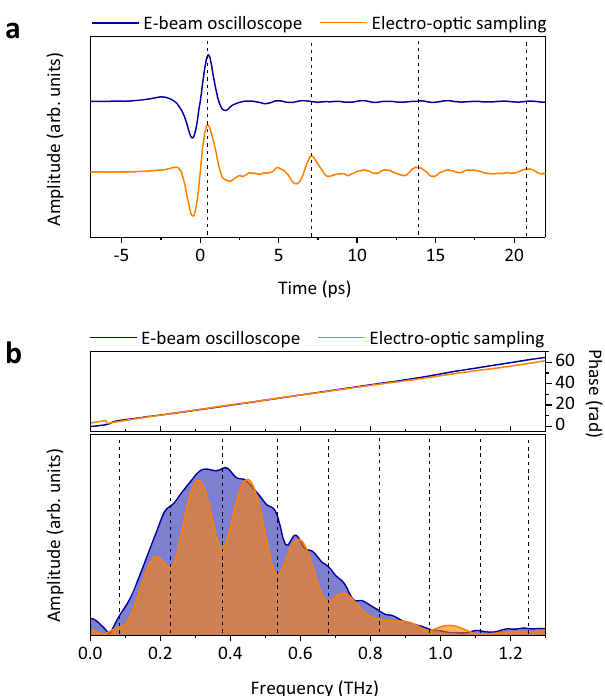
Fig. 3 Waveform comparison with conventional EOS. a Single-shot THz waveform recorded by the electron beam (E-beam) oscilloscope, and time trace of the THz fi eld obtained by the EOS technique with an optical delay scan. The vertical dashed lines indicate the positions of the main and echo signals. b Fourier-transformed spectra of THz signals in the time domain ( a ), and their phase information. The amplitudes of both spectra are normalized for clarity of comparison. The vertical dashed lines indicate the periodicity of the spectral